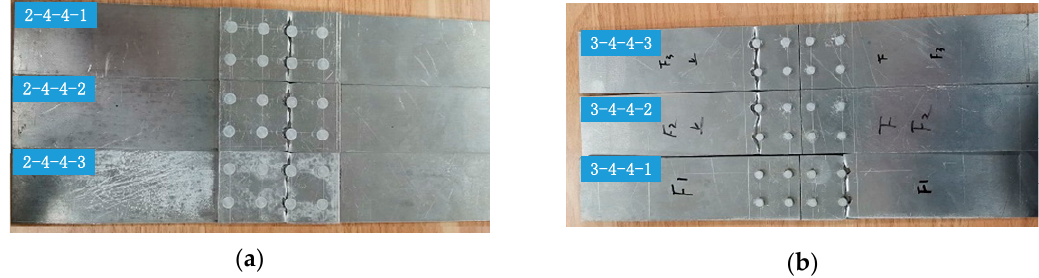
Figure 21. Typical fatigue crack morphology of specimens. ( a ) Three specimens of group 2-4-4, crack sites are on straps and ( b ) three specimens of group 3-4-4, crack sites are on plates. The relationships between fatigue lives of riveted joints and the strap thickness and rivets sizes are shown in Figure 22. It should be noticed that the X -axis represents the rivets arrangements, as an example, the 5-4-4-5 represents that the diameter of the 1st and 4th columns of rivets is 5 mm, the 2nd and 3rd is 4 mm. The Y -axis is the average fatigue life of the riveted joints.